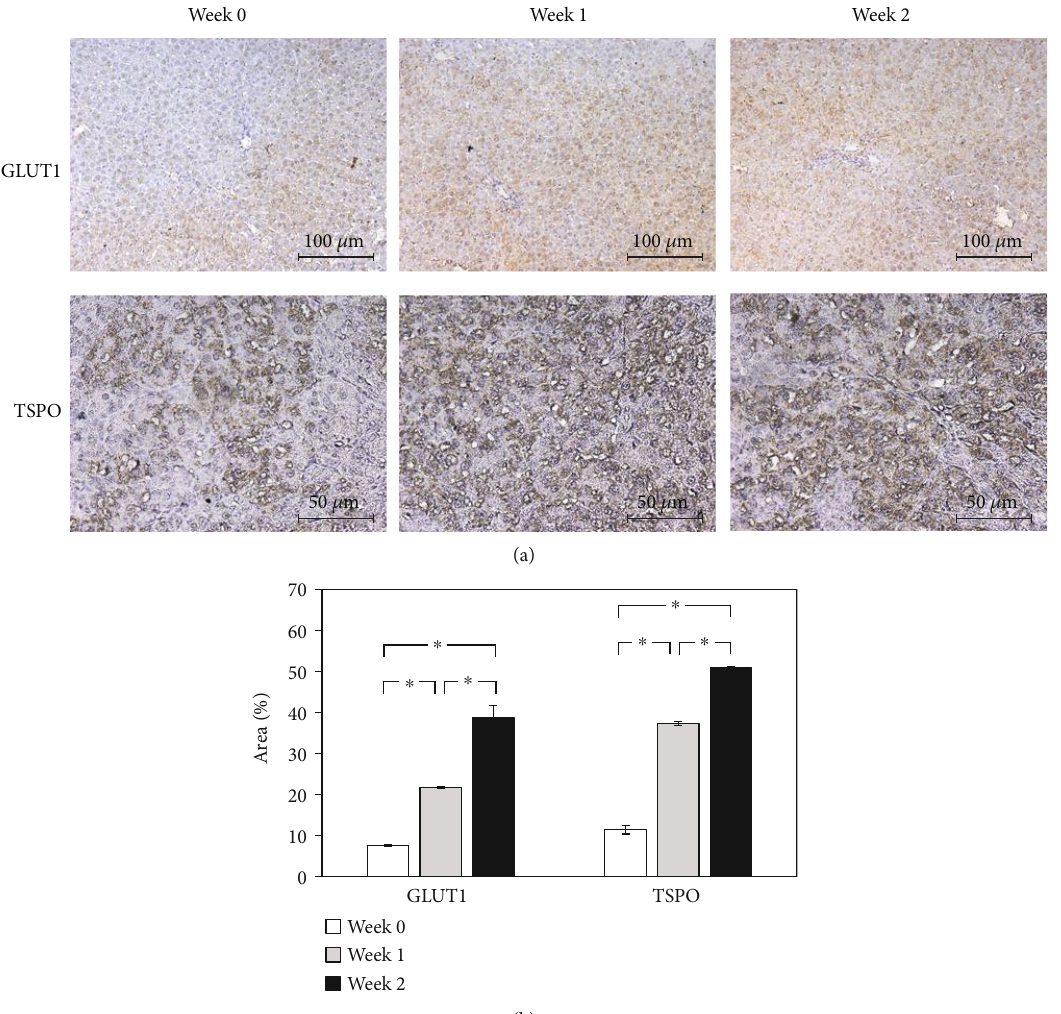
Figure 6: Immunohistochemistry (IHC) staining of livers for glucose transporter 1 (GLUT1) and anti-translocator protein (TSPO). (a) IHC images before and after bile duct ligation. (b) Quantitative analysis of the expression in the IHC images. ∗ P < 0 : 05